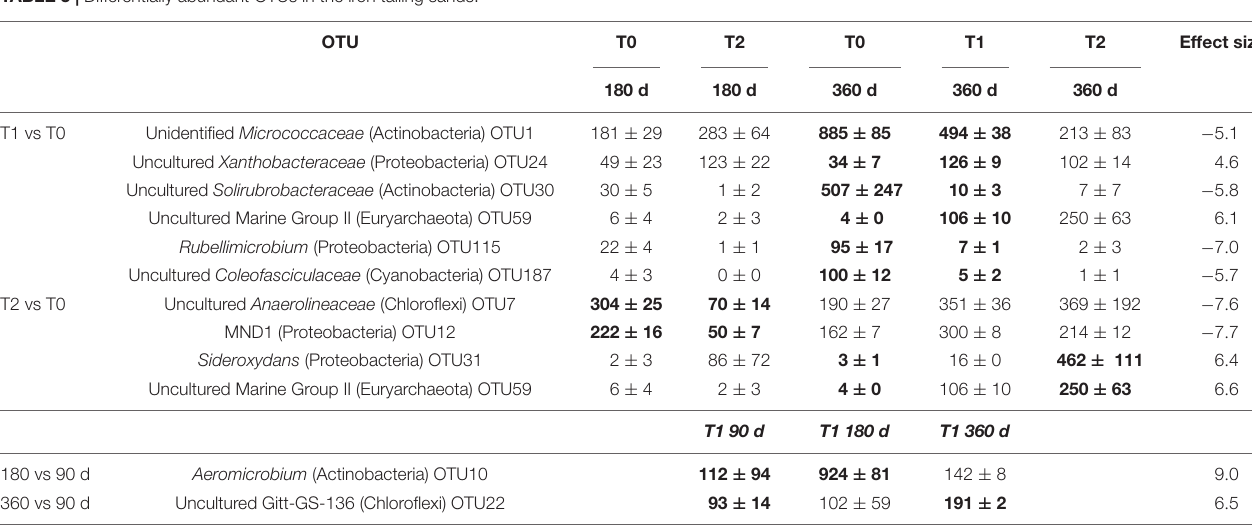
( Figure 7A ). The predicted C cycle biosynthesis and